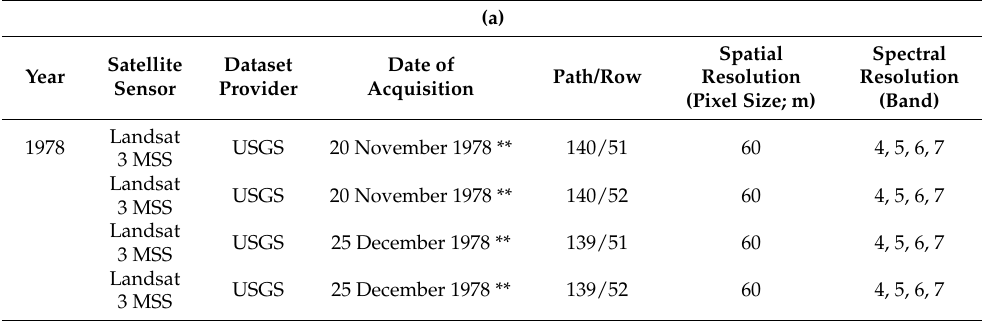
plains, rainfed plantations on hilly lands, non-farm activities (civil servants, casual workers, home business such as shops, production of local snacks, and fishery) Source: [19]. Table 2. ( a ) Year of acquisition, satellite sensors, dataset providers, dates of acquisition, paths and rows (Landsat senses), and spatial (pixel size; m) and spectral resolutions (bands) of the satellite datasets used for land use and land cover (LULC) changes and transformation analysis in Kyunsu township of Southern Myanmar. ( b ) Description and wavelength ( µ m) of the bands of satellite sensors of Landsat 3, Landsat 5, and Landsat 8 datasets used for our study in Kyunsu township of Southern Myanmar